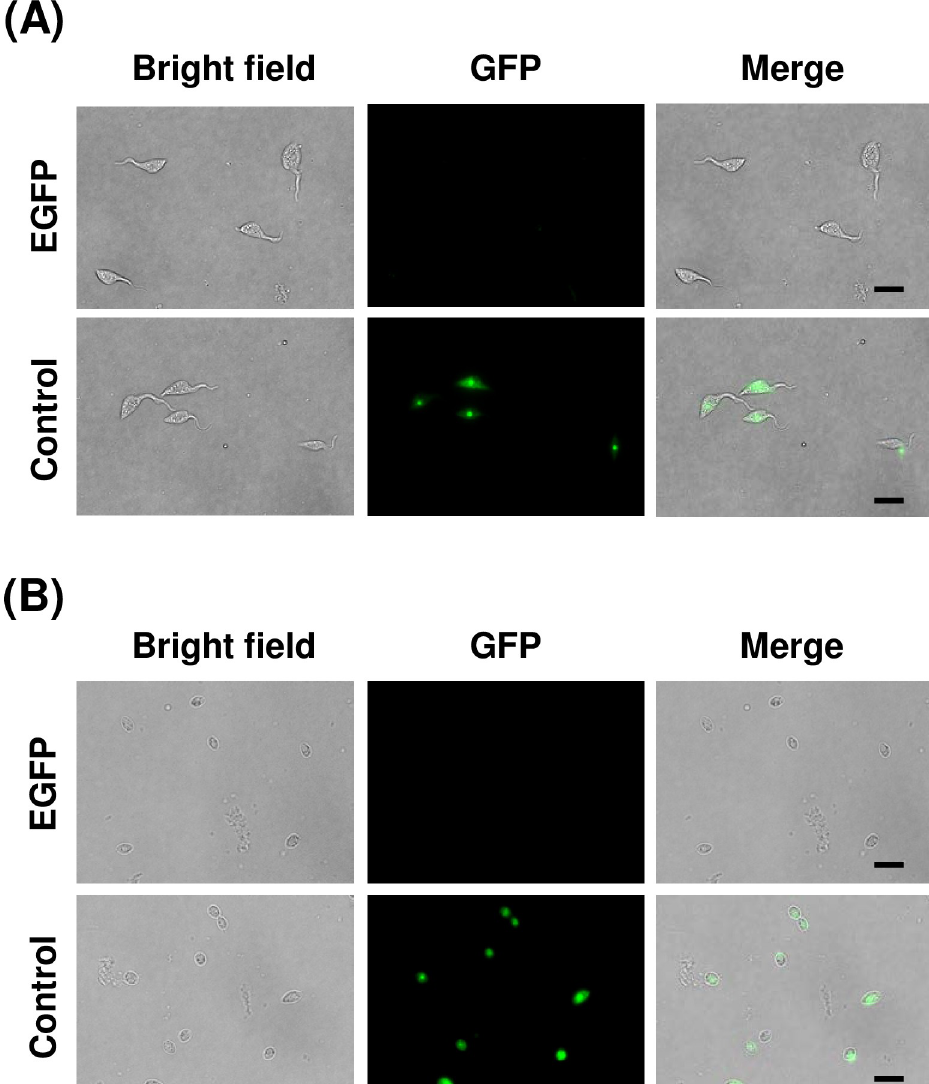
against EGFP and control gRNA were transfected into EA derived from Cas9-ama cell line. The pictures were taken at 1 day after electroporation. Scale bars: 10 μ